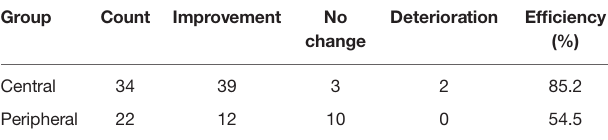
TABLE 4 | Comparison of olfactory dysfunction scores. TABLE 5 | Comparison of olfactory